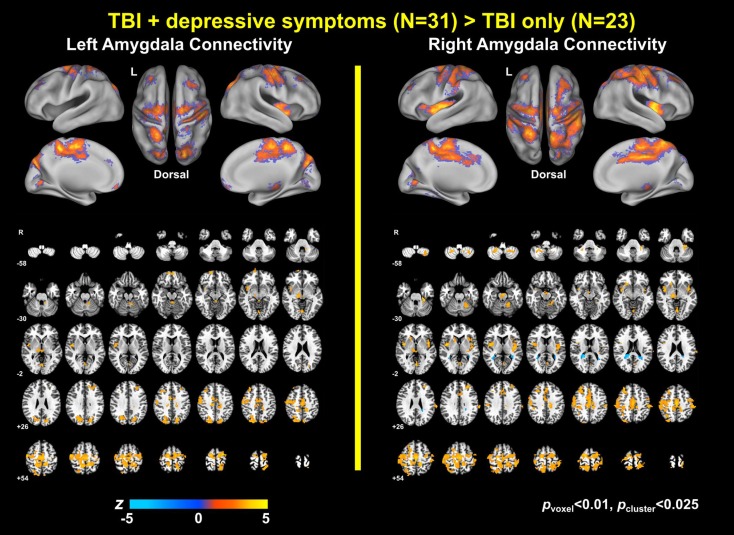
Group comparison maps of amygdala connectivity.